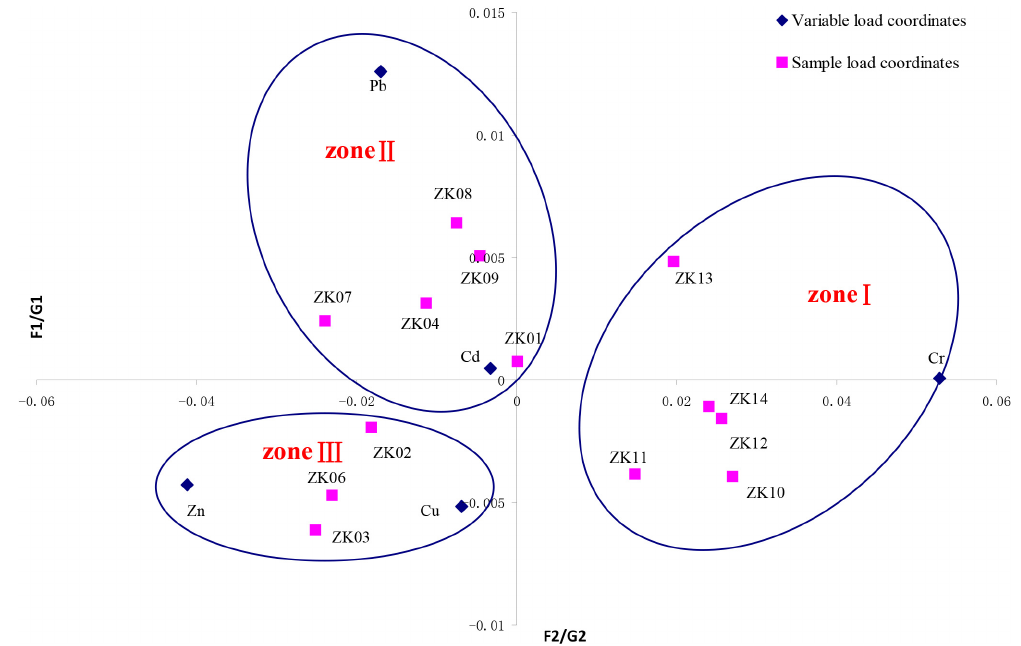
Figure 4. Correspondence map of the relationship between heavy metals and sampling points.